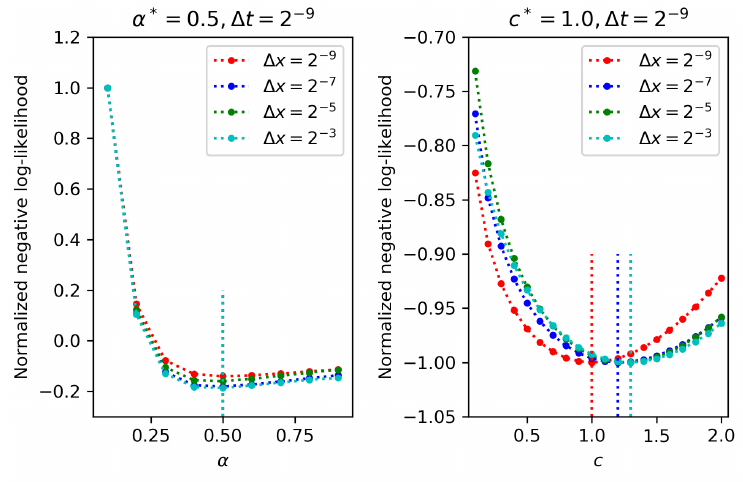
Figure 3. One-parameter estimation: Negative log-likelihood curves for varying α ∈ [ 0.1,0.9 ] and fixed c ∗ = 1.0 ( left ) and for varying c ∈ [ 0.1,2 ] and fixed α ∗ = 0.5 ( right ). The effect of spatial step on the optimal parameters is demonstrated. The noise magnitude is fixed to (cid:101) ∗ = 0.1. Full observation and partial observation curves are displayed in different colors. As these curves have y values with several orders of magnitude, for convenience of comparison, the y values are normalized by dividing the y values of each curve by their maximum absolute values. The temporal step is fixed to that of full observation, i.e., ∆ 0 t = 2 − 9 ; the spatial steps vary, and ∆ x = 2 − 9 corresponds to the full observation case, while the other three spatial steps correspond to the partial observation cases with r x = 4,16, and 64. The vertical dotted lines intersect x -axis at the optimal α or c that minimizes the normalized negative log-likelihood. The optimal parameters are regarded as the estimated parameters. Note that a vertical line having a specific color corresponds to the likelihood curve having the same color, and vertical lines can overlap each other when the optimal parameters are the same.